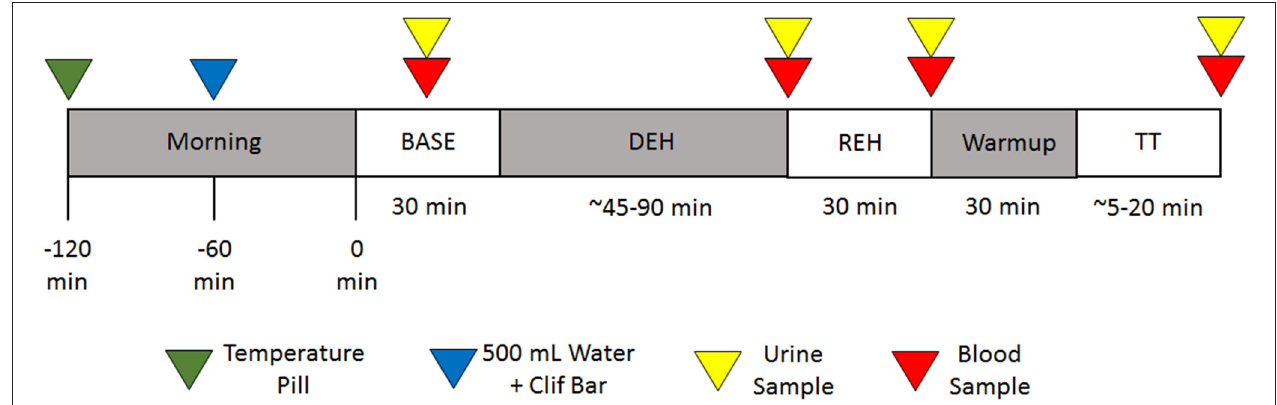
FIGURE 1 | Timeline of the